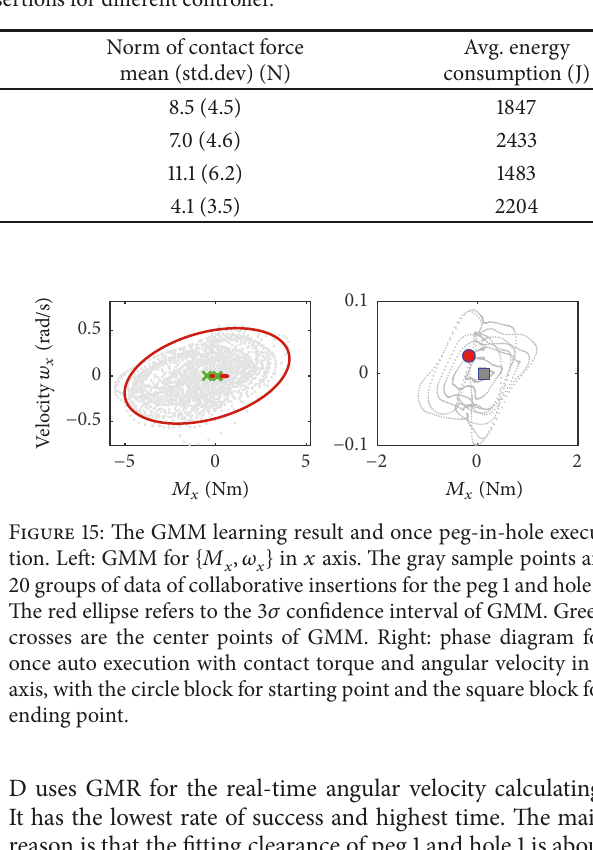
Figure 14: The snapshots for peg-in-hole execution. (a) Moving towards the hole. (b) and (c) Searching hole. (d)–(g) Adjustment based on sensed wrench. Table 2: Result comparison of insertions for different controller.